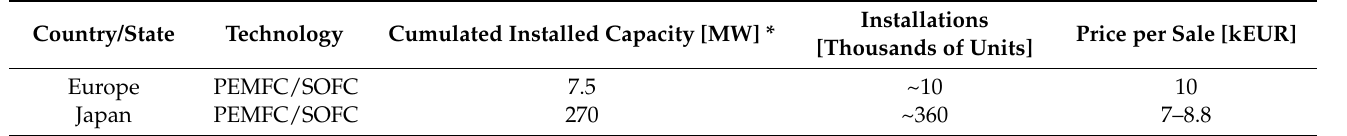
Table 1. PEMFC and SOFC, micro-CHP installation.